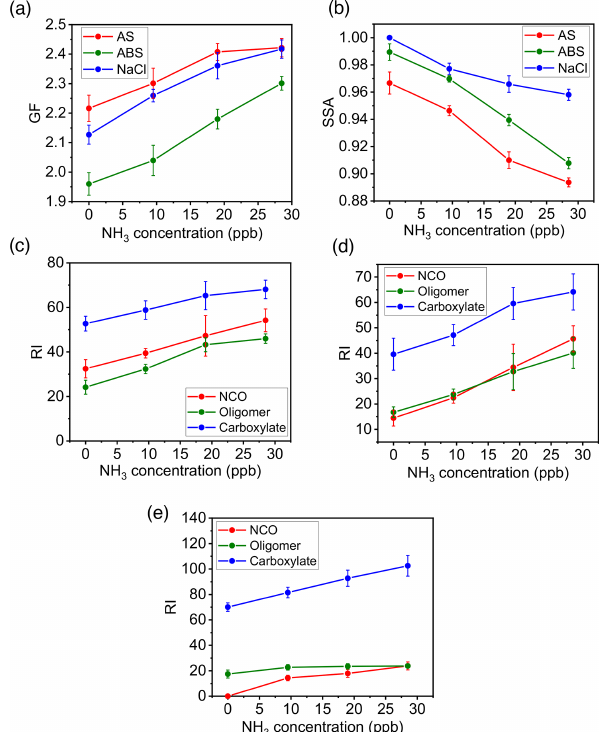
Figure 4. Variation of SOA formation with seed particles and NH 3 concentration. (a, b) Growth factor (a) and SSA (b) at t = 120min with varying NH 3 concentration between 0 and 27ppb for am- monium sulfate (AS, red), ammonium bisulfate (ABS, green), and sodium chloride (NaCl, blue) seed particles. (c–e) Aerosol-phase mass relative intensity (RI) for NCOs (red), oligomers (green), and carboxylates (blue) on AS (c) , ABS (d) , and NaCl (e) seed particles. The error bar denotes 1 σ of three replicated measurements.